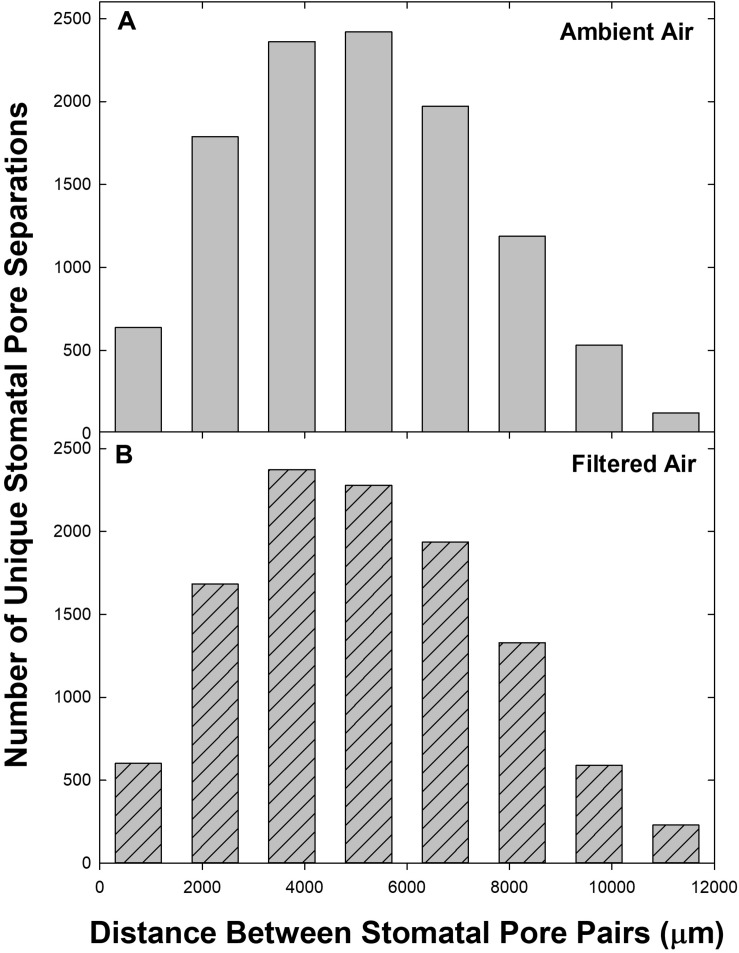
Frequency distribution of pore separations (d) among the 50 stomata measured on each of 9 leaves (n = 11,025 per panel). Distance classes: 0 ≤ d < 1500 to 10500 ≤ d < 12000, centered at 750–11250. For d ≥ 12000 (n = 20 for AA and 55 for FA) frequencies were pooled with 10500 ≤ d < 12000. (A) Ambient air; (B) filtered air.